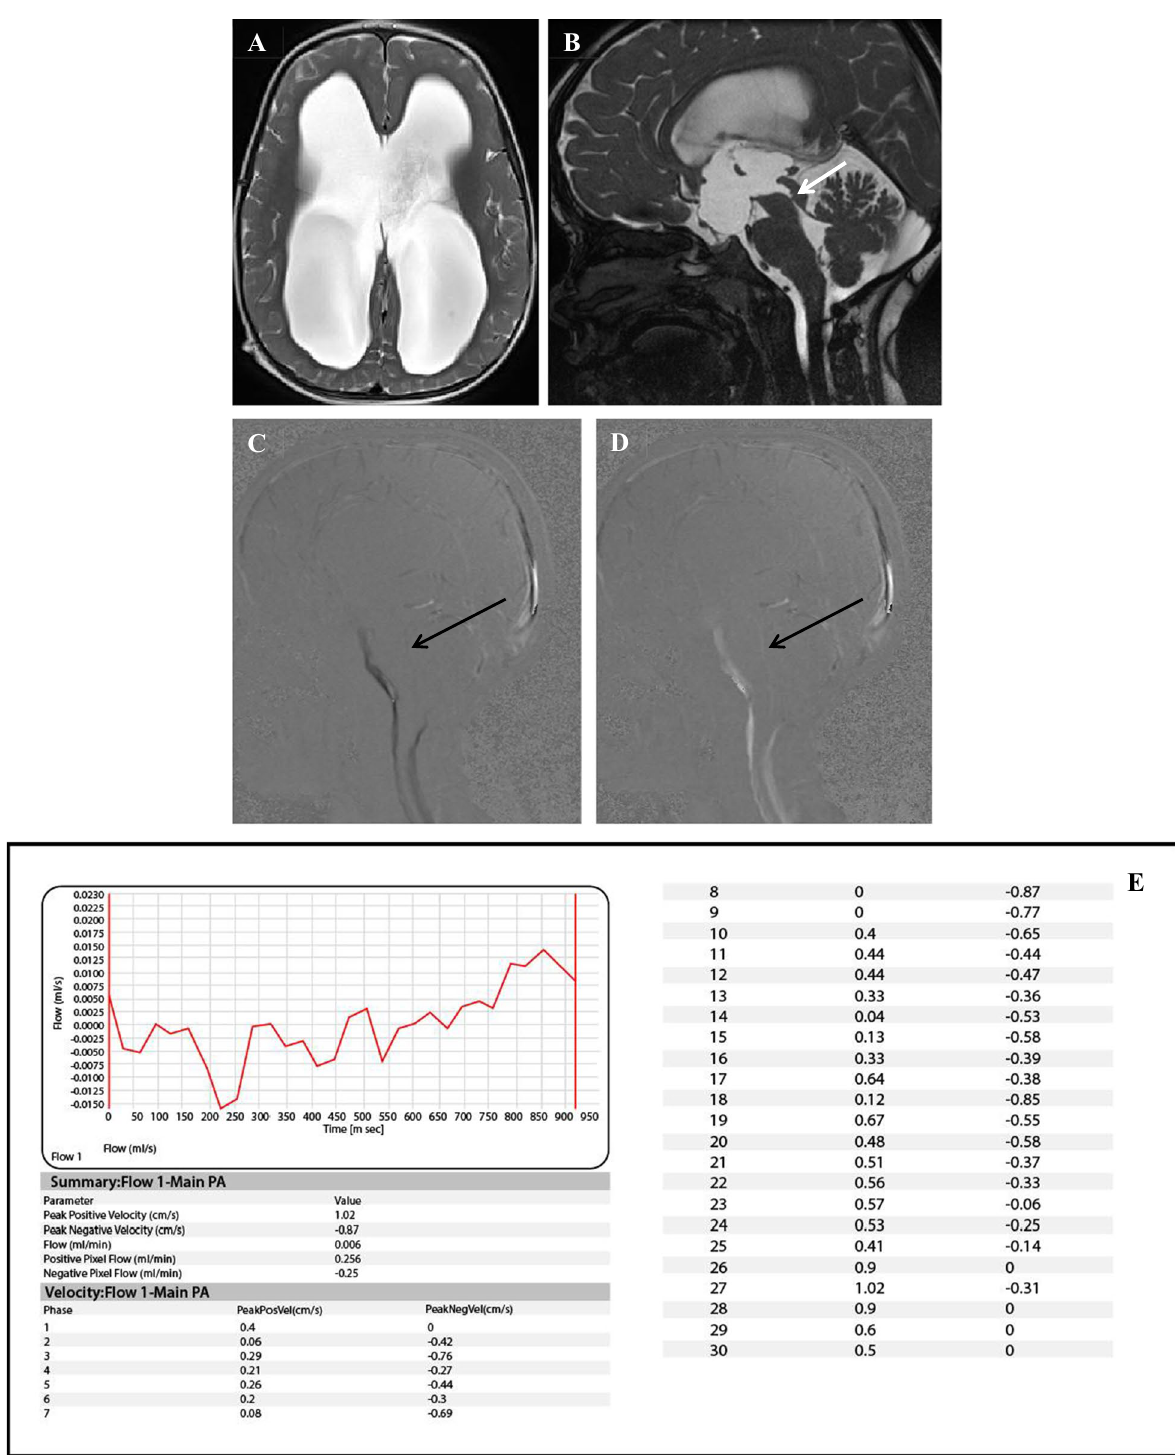
Fig. 1 A – E A 6‑year‑old female child with headache and persistent vomiting. A Axial T2W image shows mild‑to‑moderate supratentorial ventricular dilation, B sagittal T2 DIVER image reveals absent flow void at aqueduct of Sylvius which is obstructed by aqueductal web (white arrow). C , D Sagittal phase‑contrast images reveal no CSF flow through the aqueduct at systole ( C ) and diastole ( D ) (black arrows), and E velocity time curve‑ and CSF flow curve‑associated table reveals irregular CSF flow curve indicating irregular to and fro movement of the CSF proximal to the site of obstruction with PSV: 0.8 cm/s, PDV:1.02 cm/s, and MV: 0.4 cm/s (hypodynamic CSF circulation with low CSF velocities and no flow through aqueduct of Sylvius obstructive hydrocephalus due to aqueductal